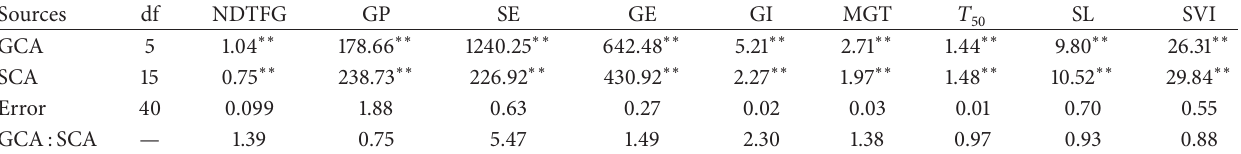
Table 1: Combining ability ANOVA for nine germination traits of 6 × 6 diallel populations in Jatropha curcas . Sources